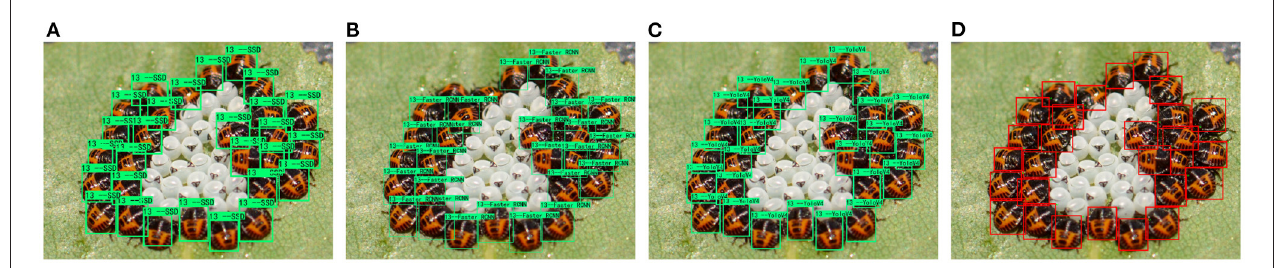
FIGURE 6 | Small sample detection results on our Forestry Pest Dataset. (A) SSD, (B) Faster RCNN, (C) YOLOV4, and (D) Deformable DETR.